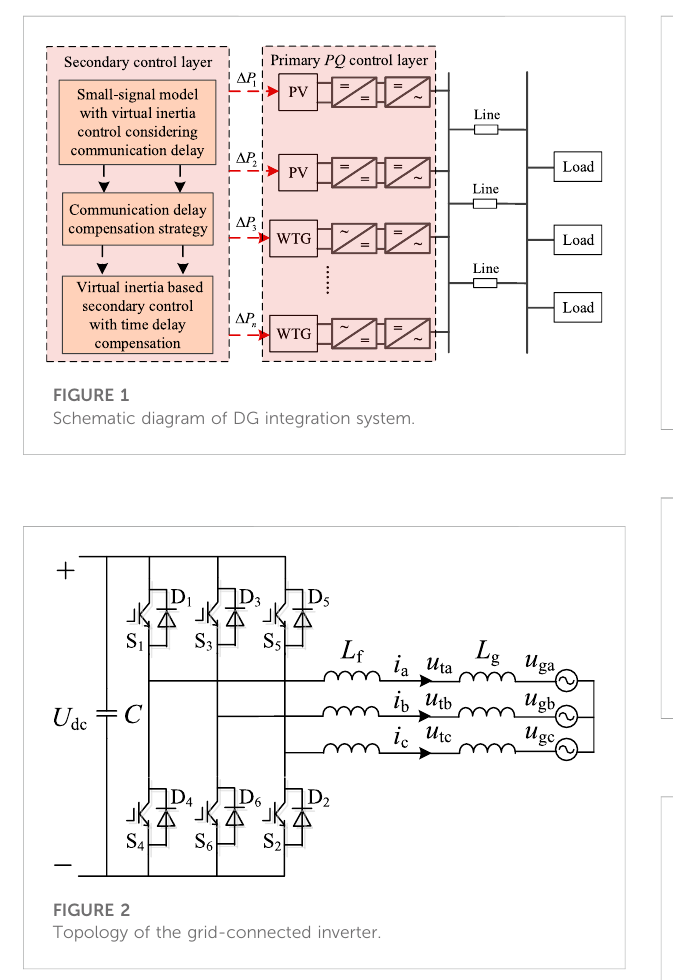
FIGURE 2 Topology of the grid-connected inverter.